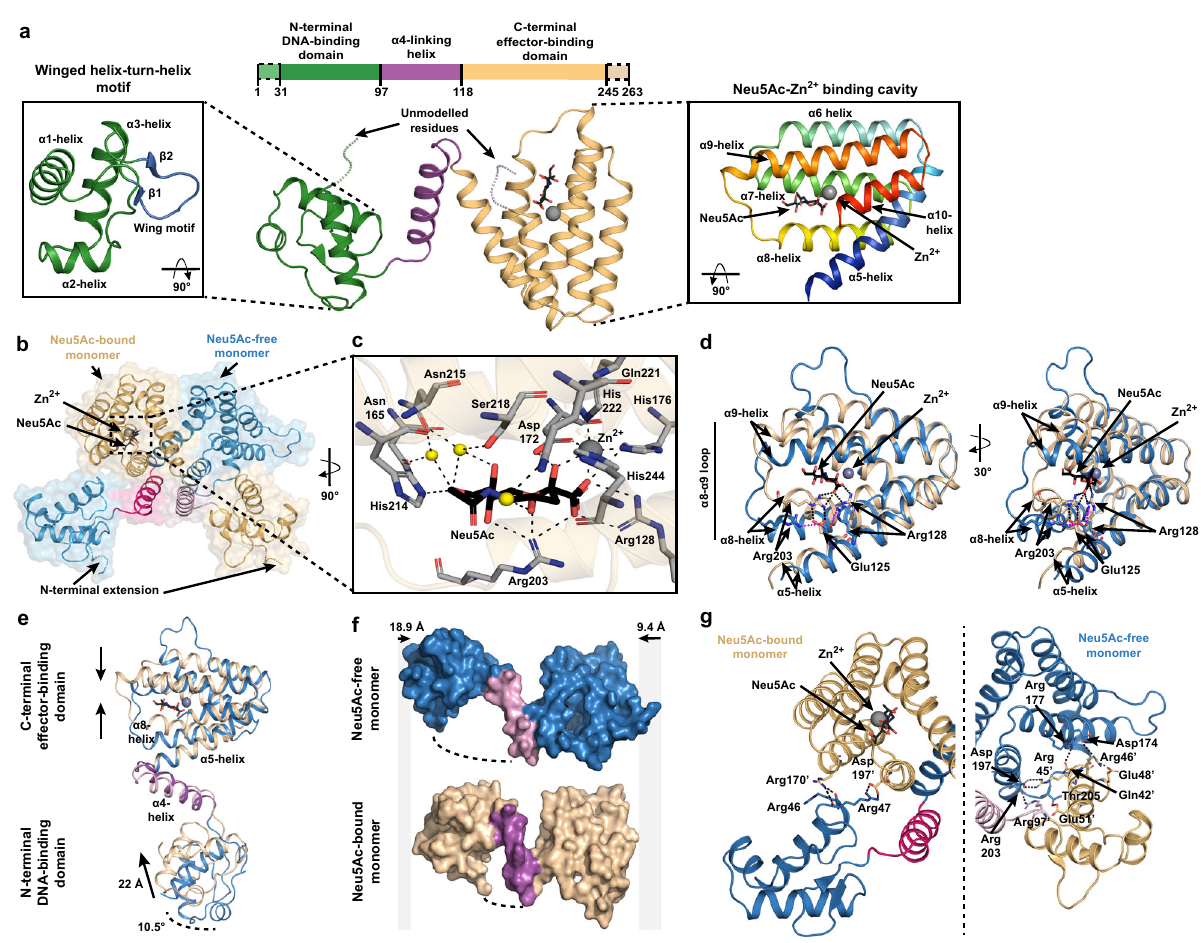
Fig. 4 Crystal structure of NanR in complex with Neu5Ac and Zn 2 + . a The E. coli NanR monomer has two domains — an N-terminal DNA-binding domain (green) and C-terminal effector-binding domain (beige). The DNA-binding domain contains a highly conserved winged helix – turn – helix motif (left panel) where the wing is de fi ned by an antiparallel two-stranded β -sheet (blue). The C-terminal domain is arranged into an antiparallel, all- α -helical bundle (right inset, rainbow). Helix α 4 (purple) is a fl exible linker connecting the two domains. b Cartoon/surface representation of the asymmetric domain-swapped dimeric structure formed by an exchange between monomers via the α 4-helix (pink). The Neu5Ac-bound and Neu5Ac-free monomers are shown in beige and blue, respectively. c The effector binding site is located within a large polar cavity of the C-terminal domain. The direct or water-mediated hydrogen- bonding residues (gray sticks) that coordinate Neu5Ac in its β -anomeric form and hold Zn 2 + in an octahedral geometry are indicated, while water molecules are depicted as yellow spheres. d An overlay of the Neu5Ac-bound C-terminal domain (beige) and Neu5Ac-free C-terminal domain (blue) illustrates the effector-induced conformational changes. e An overlay of the Neu5Ac-bound monomer (beige) and Neu5Ac-free monomer (blue) further illustrates effector-induced conformational changes. f Surface depiction of Neu5Ac-bound (beige) and Neu5Ac-free (blue) monomers shows that the binding of Neu5Ac compresses the monomer around the α 4-helix (purple) relative to the Neu5Ac-free monomer by 28.3 Å. g Cartoon representation of the interface between the Neu5Ac-bound monomer (beige) and the Neu5Ac-free monomer (blue), facilitated by salt-bridge